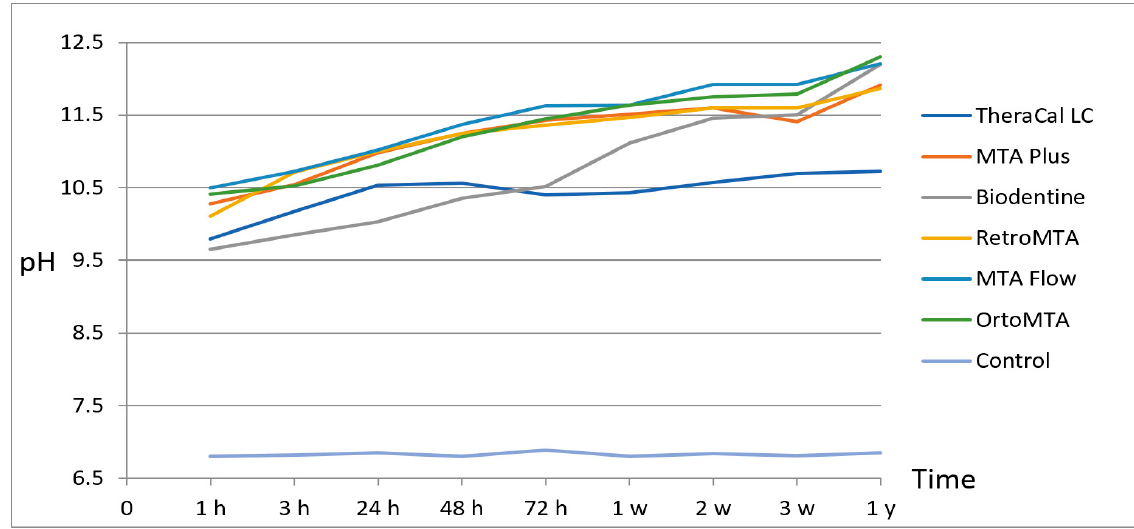
Figure 1. pH changes of materials tested during the course of time of the experiment.